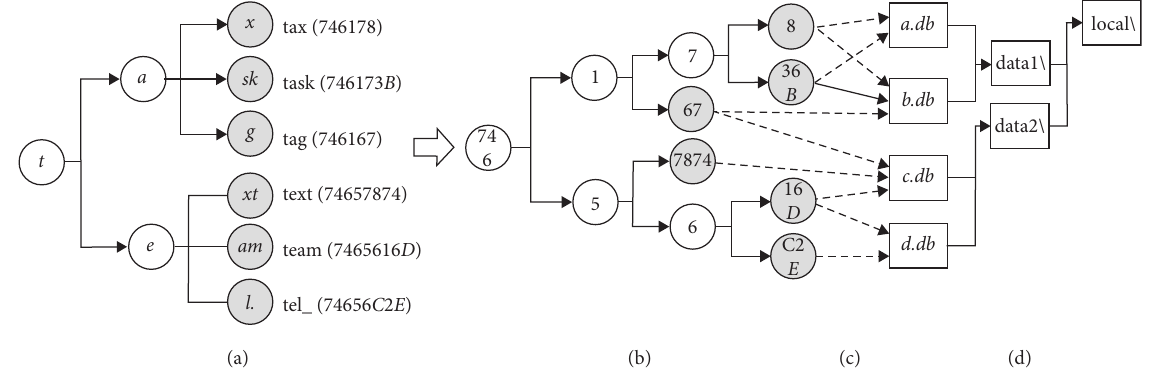
Figure 6: Example of ATree, DTree, and ADLinks. (a) ATree with characters. (b) ATree with UTFS. (c) ADLinks. (d)